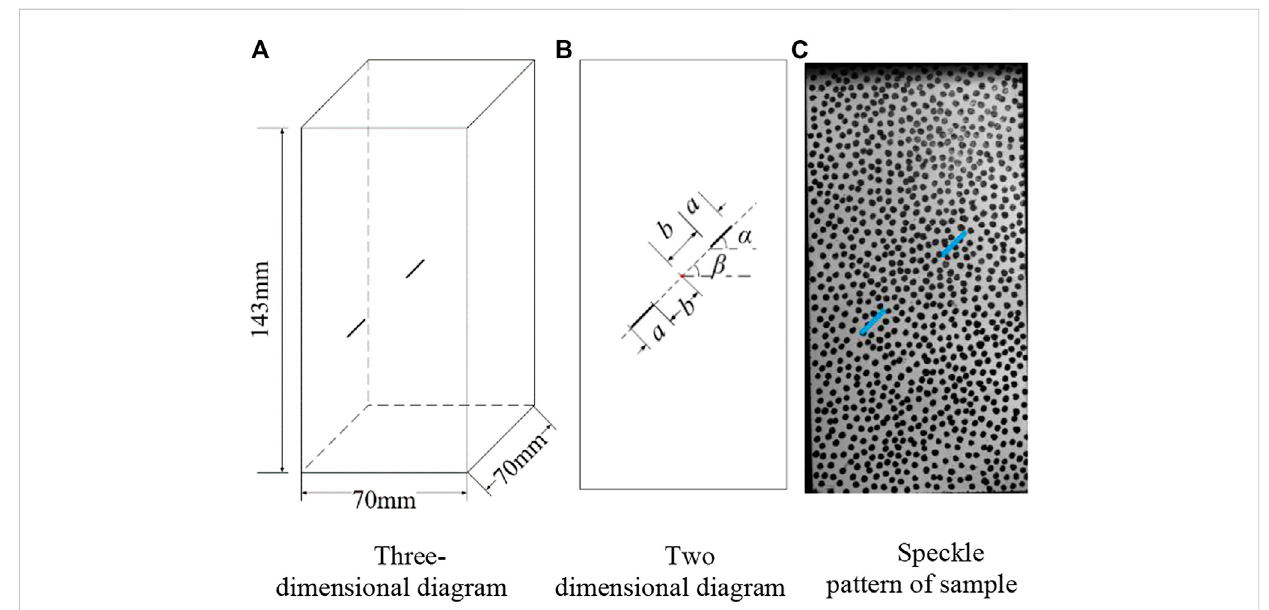
FIGURE 4 Distribution diagram of coplanar double fi ssures. (A) Three-dimensional diagram; (B) Two dimensional diagram; (C) Speckle pattern of sample.